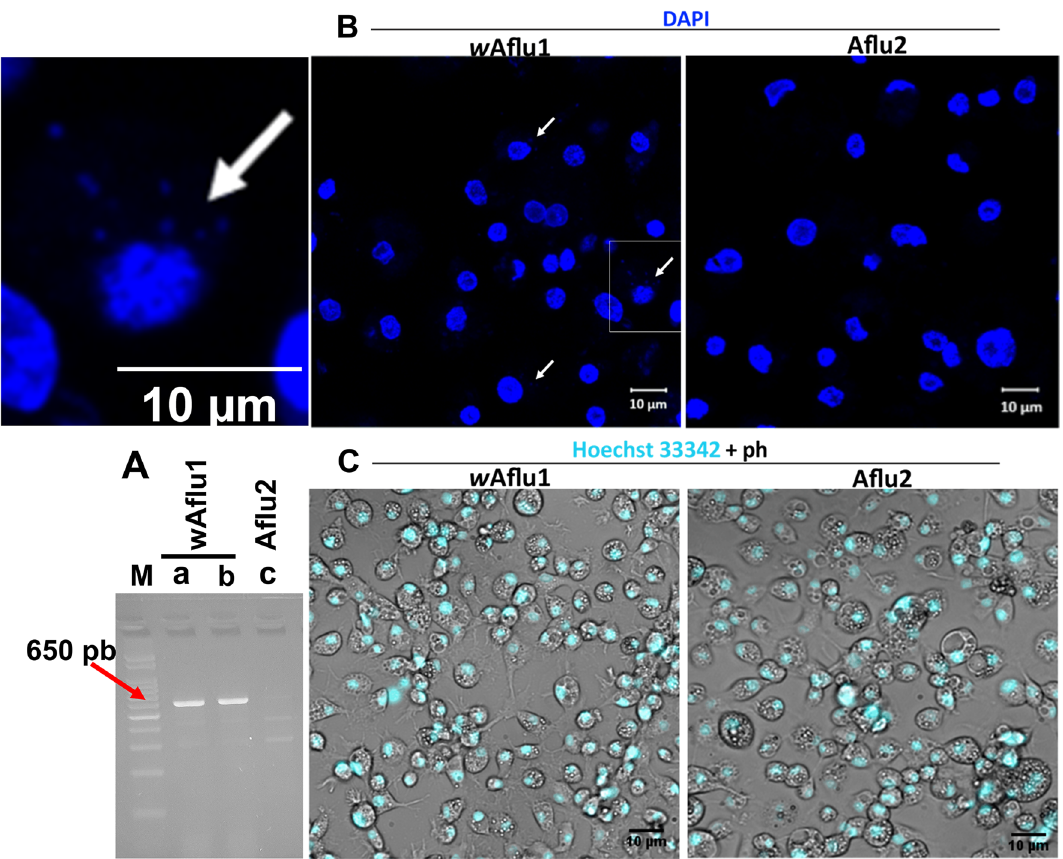
Figure 2. Aedes fluviatilis embryonic cell lines w Aflu1 and Aflu2. Embryonic cell line w Aflu1 was positive for the Wolbachia-specific gene, WSP, which was absent in Aflu2 cells ( A , lane a and c, respectively). Amplification